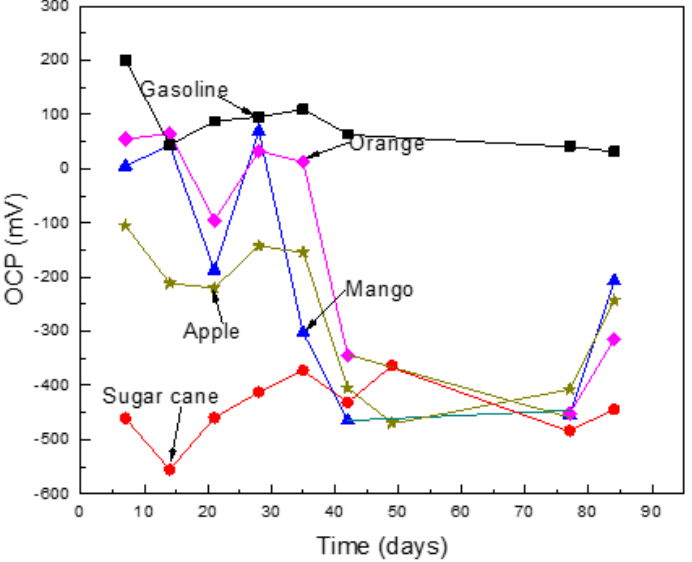
Figure 2. Variation on the open circuit potential (OCP), value for Al in the different ethanol–gasoline blends.